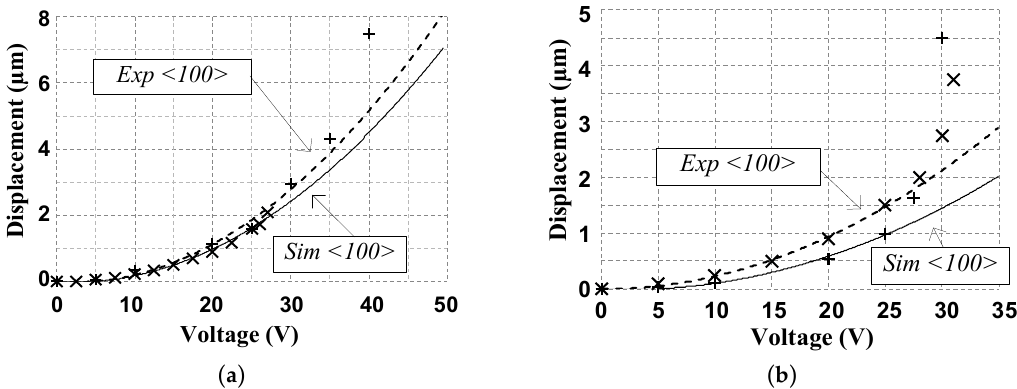
Figure 14. Latch actuation for <100> anchor orientation showing ( a ) locked latch at 40 V and ( b ) open lock at 30 V where the solid line is a fit to the simulated data, and the dotted line is a fit to the experimental data.